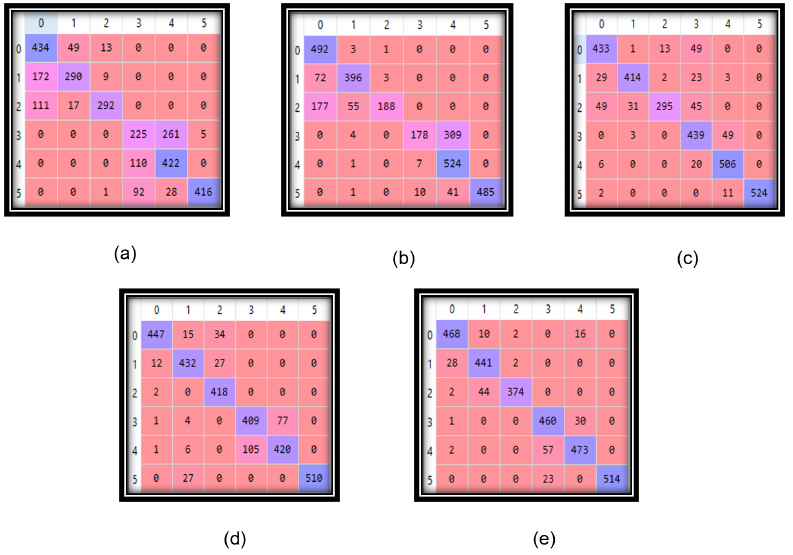
Figure 5. Confusion matrix of the ( a ) RF, ( b ) k-NN ( c ) SVM ( d ) ANN, and ( e )